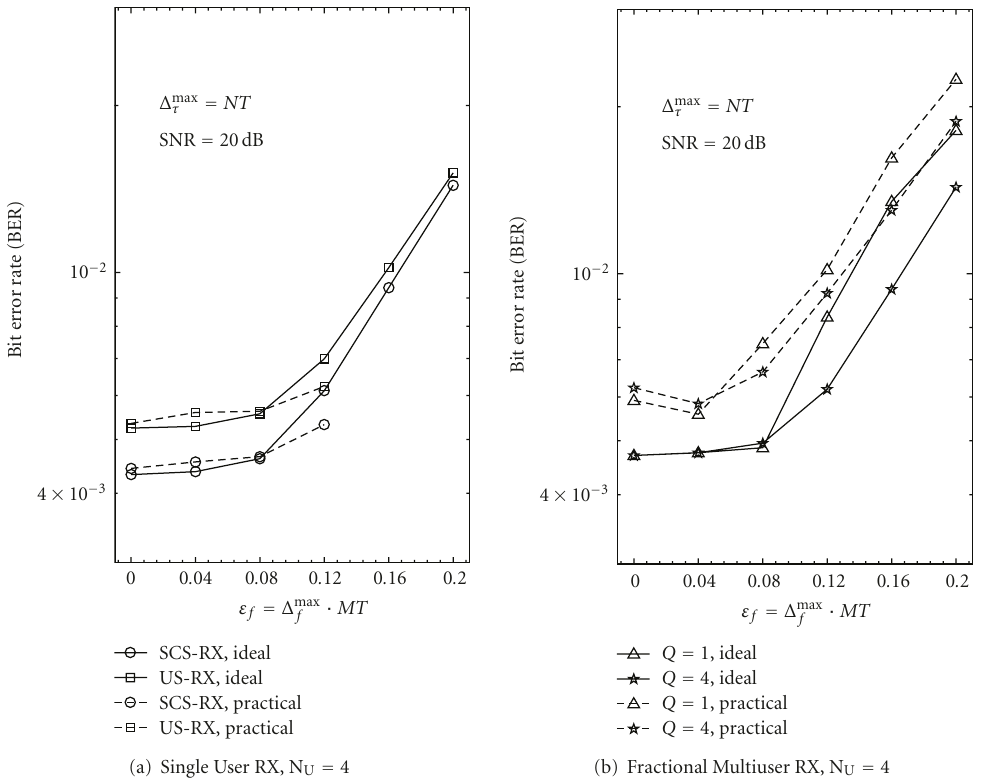
Figure 9: Average BER as a function of the maximum frequency o ff set. Ideal and practical performance with 4 users. The training sequence length is equal to 30